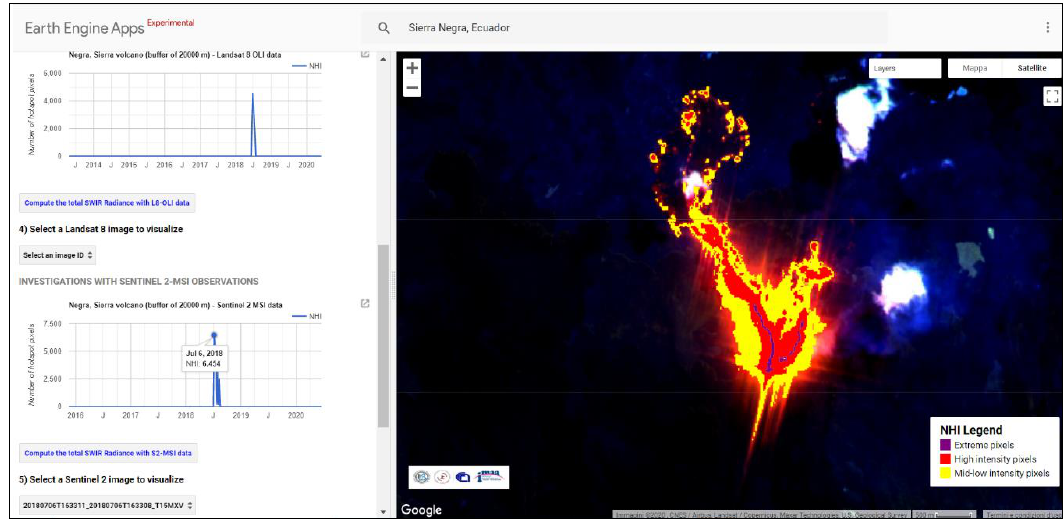
Figure 10. Sierra Negra (0.83°S 91.17°W) thermal activity of April 2013 − May 2020. On the left, temporal trend of hot spot pixel (blue curve) retrieved from L8 and S2 data. On the right, thermal anomaly map from Sentinel-2 MSI data of 6 July 2018.